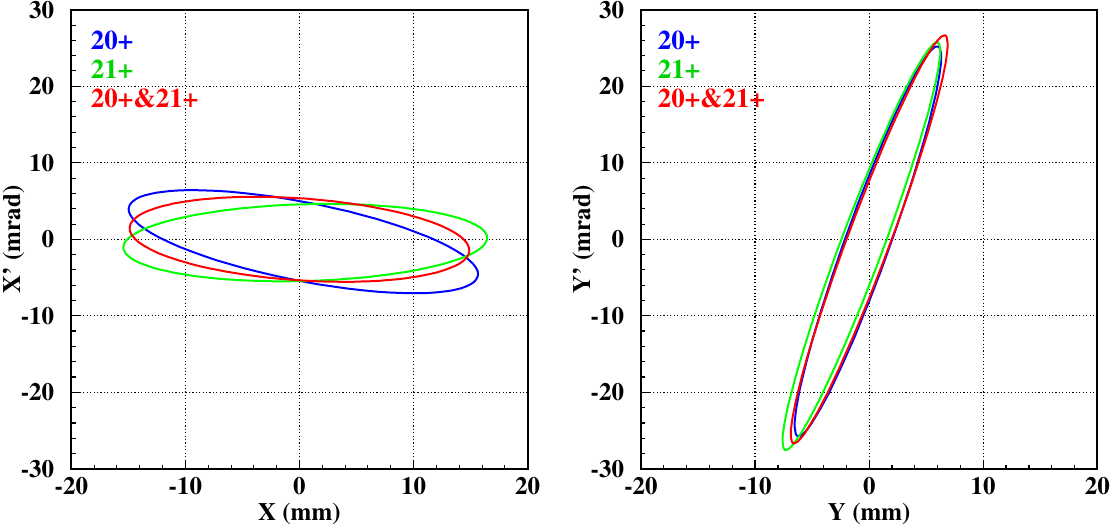
FIG. 8. (Color) Beam phase space ellipses ( 4 (cid:4) rms emittances) extracted from the pepper-pot images for individual charge states and combined bismuth